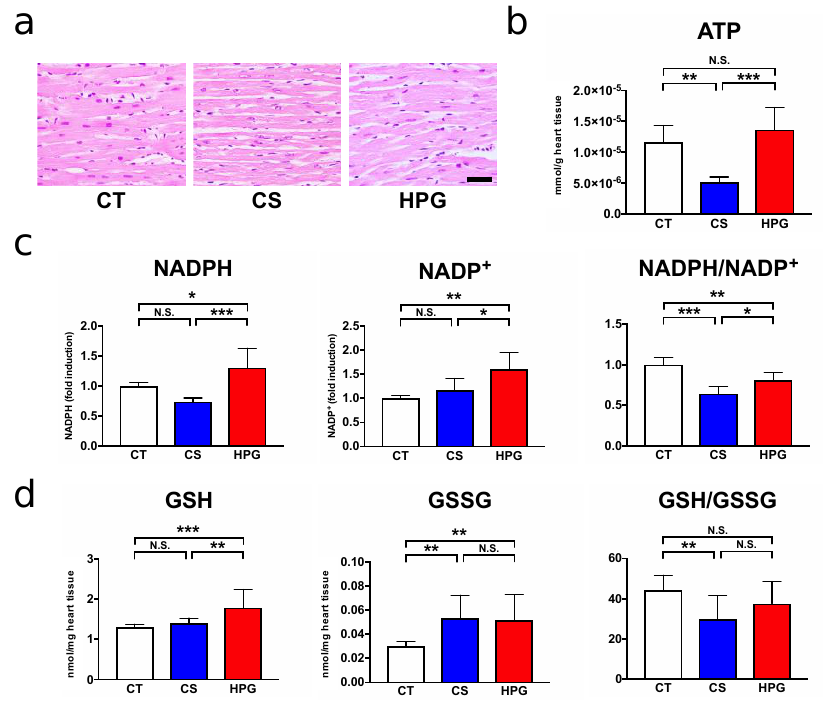
Figure 2. Assessment of cardiac morphology and mitochondrial activities after 24-h preservation. ( a ) Hematoxylin and eosin staining in hearts immediately after 24-h preservation. Black bar represents 40 μm. ( b ) Adenosine triphosphate (ATP) content. ( c ) Alterations in reduced nicotinamide adenine dinucleotide phosphate (NADPH), NADP + , and NADPH / NADP + ratio. Bar graphs indicate fold changes relative to the CT group. ( d ) Alterations in reduced glutathione (GSH), oxidized glutathione (GSSG), and the GSH / GSSG ratio. Data in each bar are presented as mean ± standard error of the mean. N.S., not significant. * p < 0.05, ** p < 0.01, *** p < 0.001. P -values were calculated by one-way ANOVA with post hoc Tukey’s multiple comparison analysis.